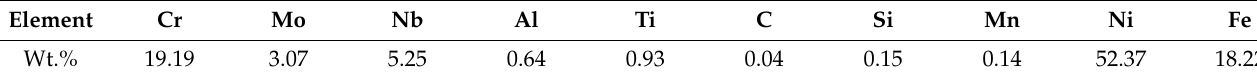
Table 1. Chemical composition of the starting IN718 powder feedstock.